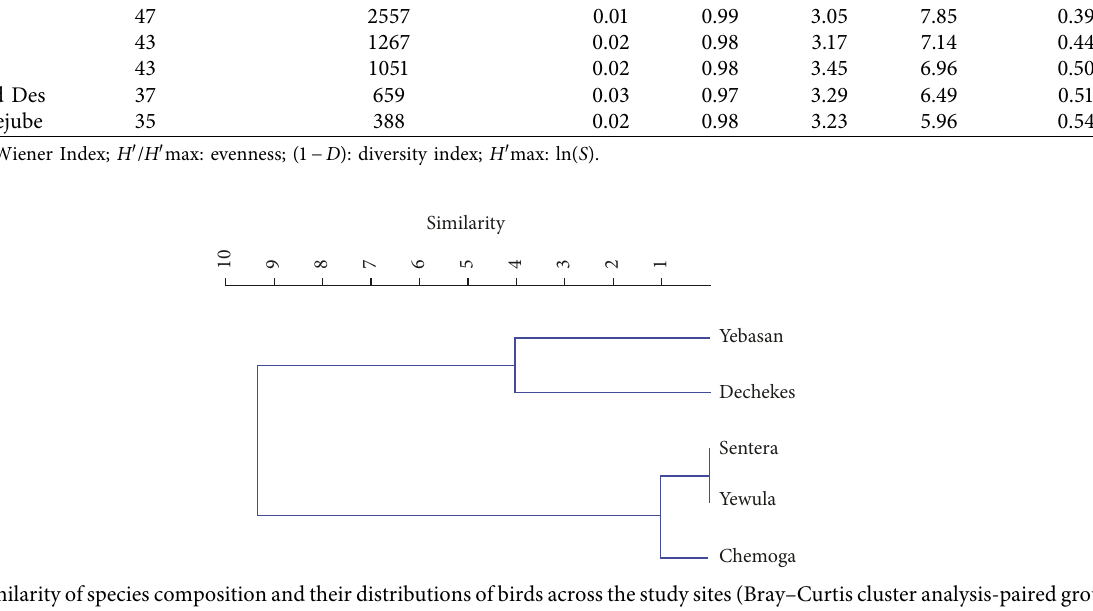
Figure 3: Similarity of species composition and their distributions of birds across the study sites (Bray–Curtis cluster analysis-paired group).